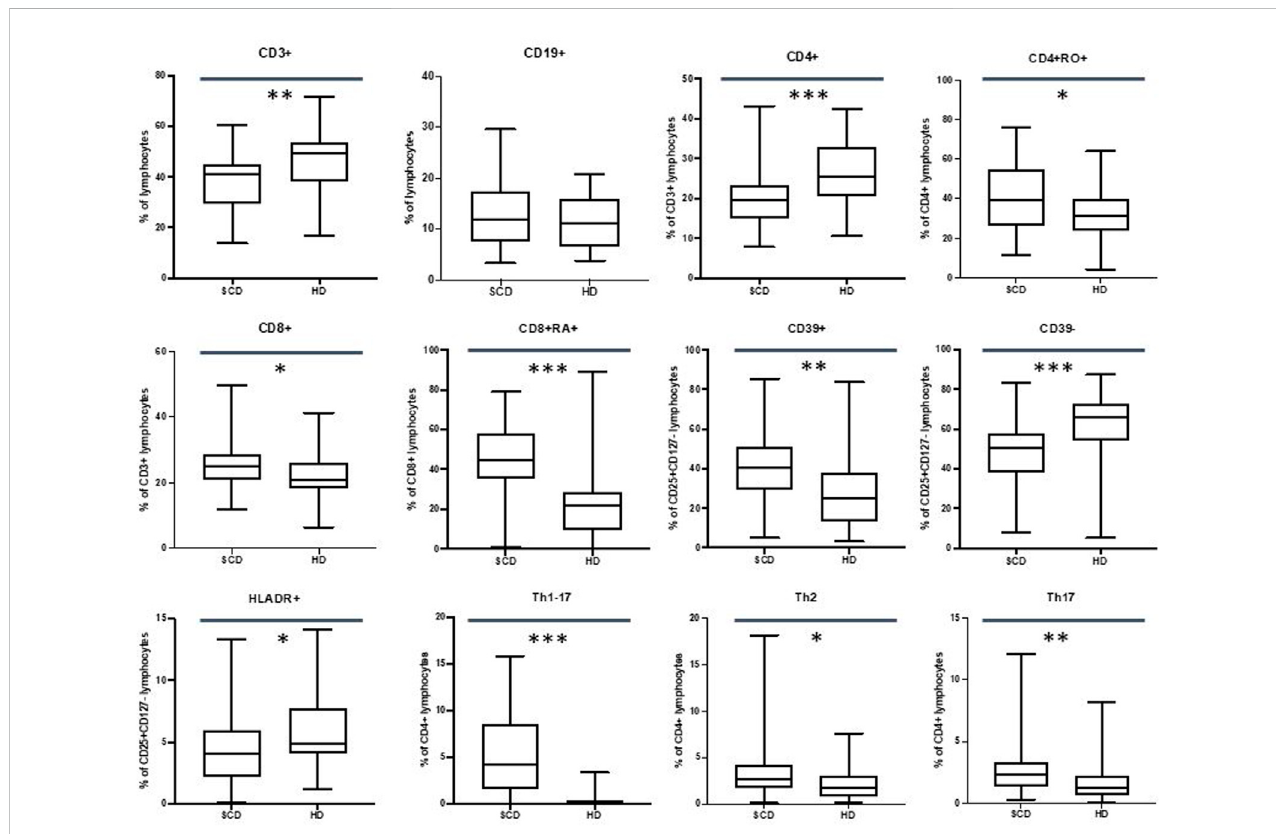
FIGURE 3 Differences in CD3 + , CD19 + , CD4 + , CD4+RO+, CD8 + , CD8+RA+, Treg CD39 + , Treg CD39 − , Treg HLADR+, Th1-Th17, Th2, Th17 lymphocytes between sickle cell disease (SCD) patients and healthy donors (HD). * p ≤ .05; ** p ≤ .01; *** p ≤